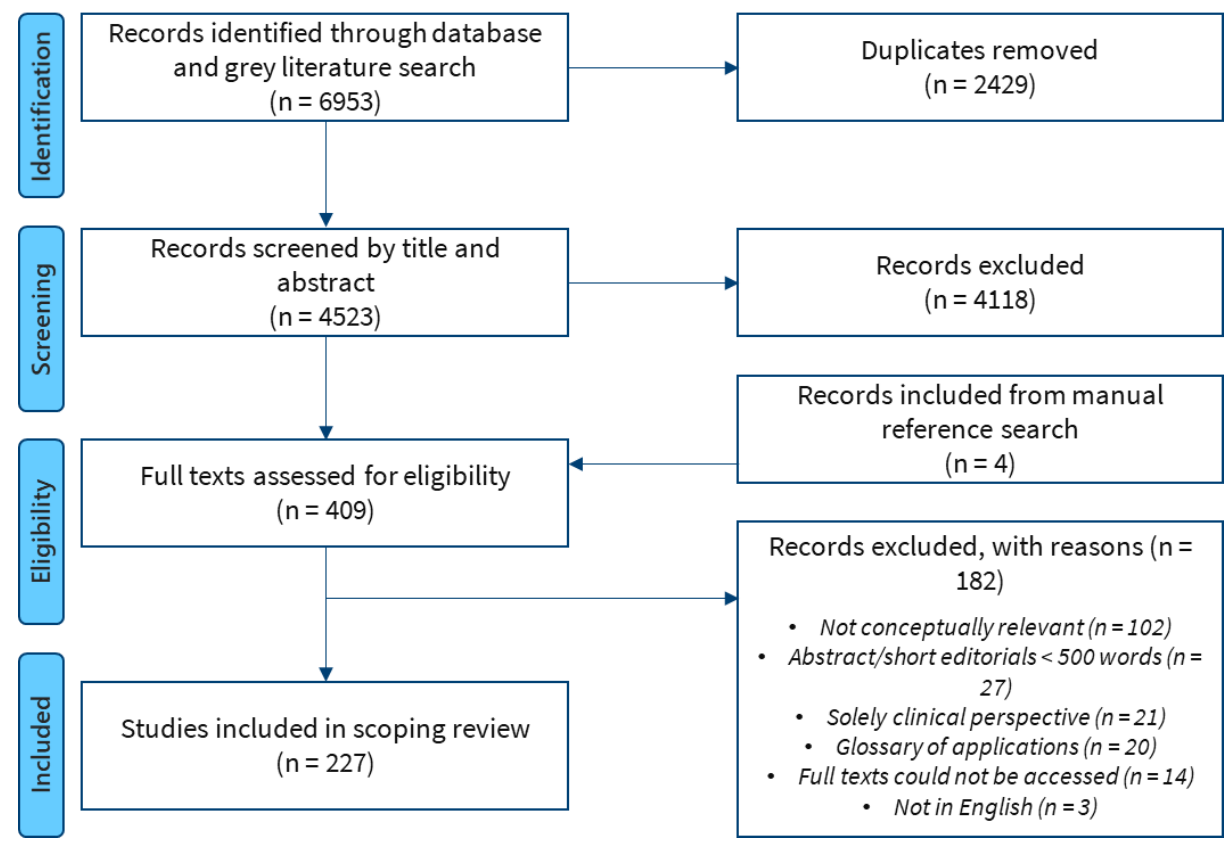
Figure 2. Preferred Reporting Items for Systematic Reviews and Meta-Analyses for Scoping Reviews (PRISMA-ScR) flow diagram of the search and study selection